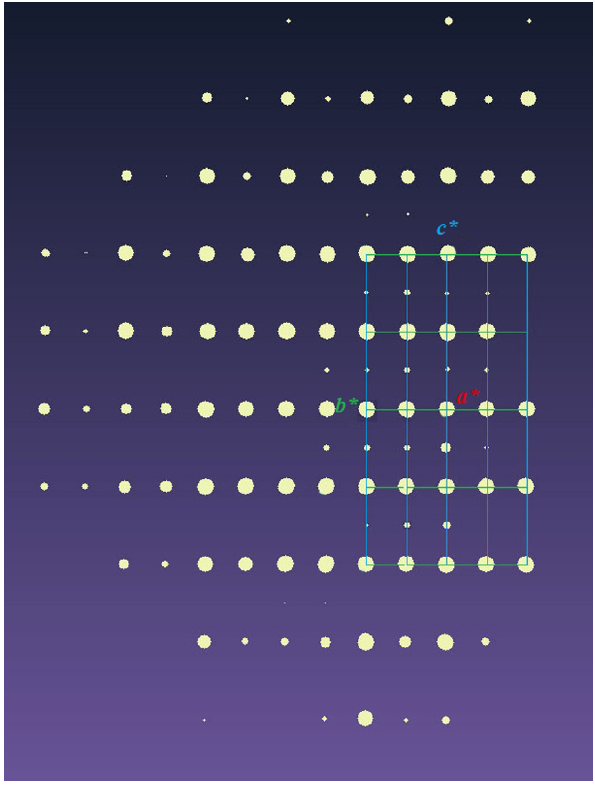
Figure 5. Single-crystal diffraction points of wumuite (view along a ∗